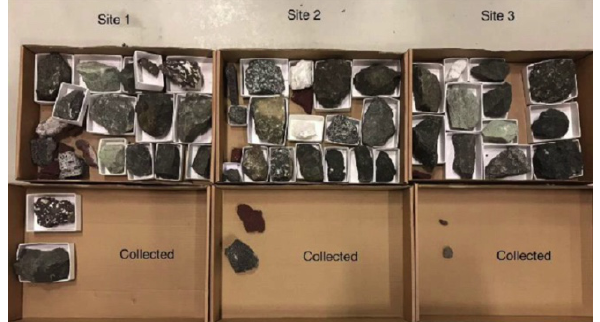
Figure 5. The rock samples used in